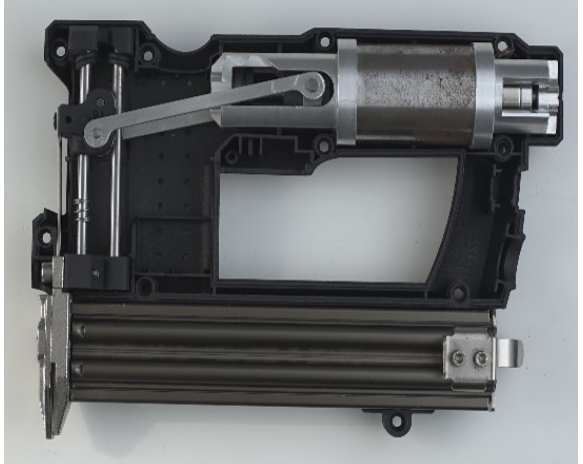
Fig. 17. Internal structure of the nail shooting device.